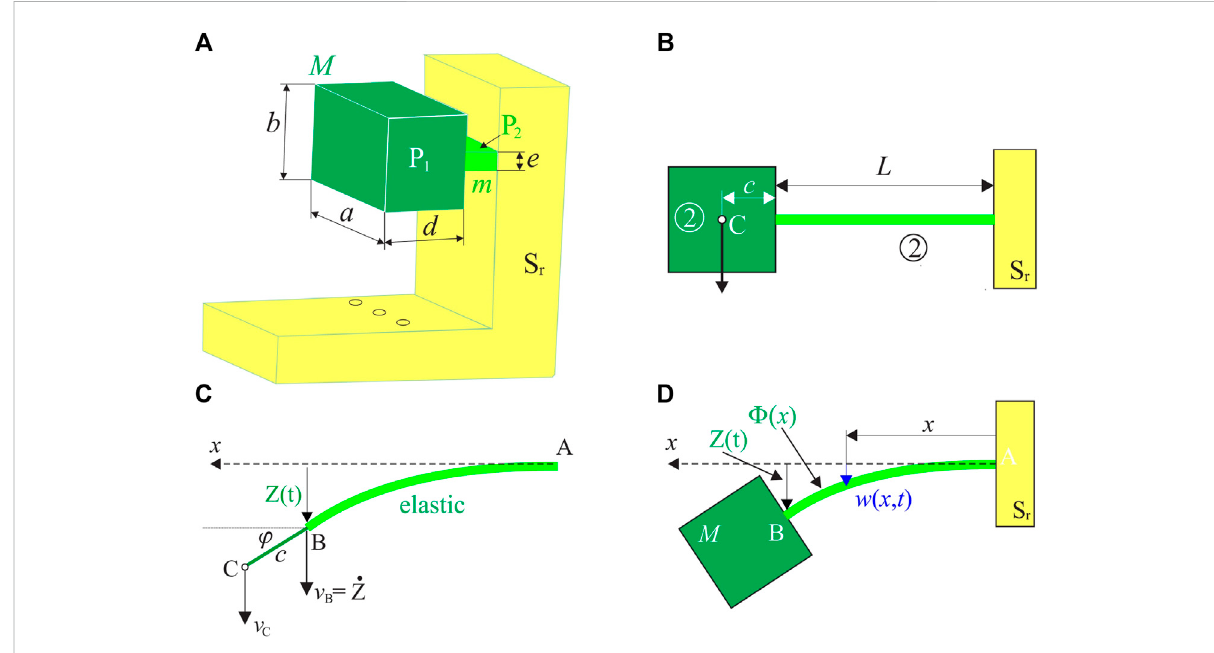
FIGURE 2 Internal oscillator: (A) 3D model; (B) presentation as a clamped beam with a concentrated mass on the top; (C) kinematics of the concentrated mass; (D) deformed con fi